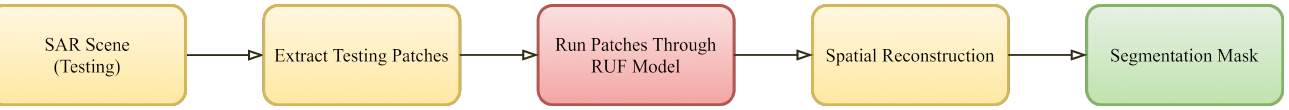
Figure 5. Model testing pipeline. Input SAR image is processed as illustrated in Figure 2 to feed patches serially to the trained RUF model for inference. These patches are then reconstructed to yield the segmentation mask for the whole